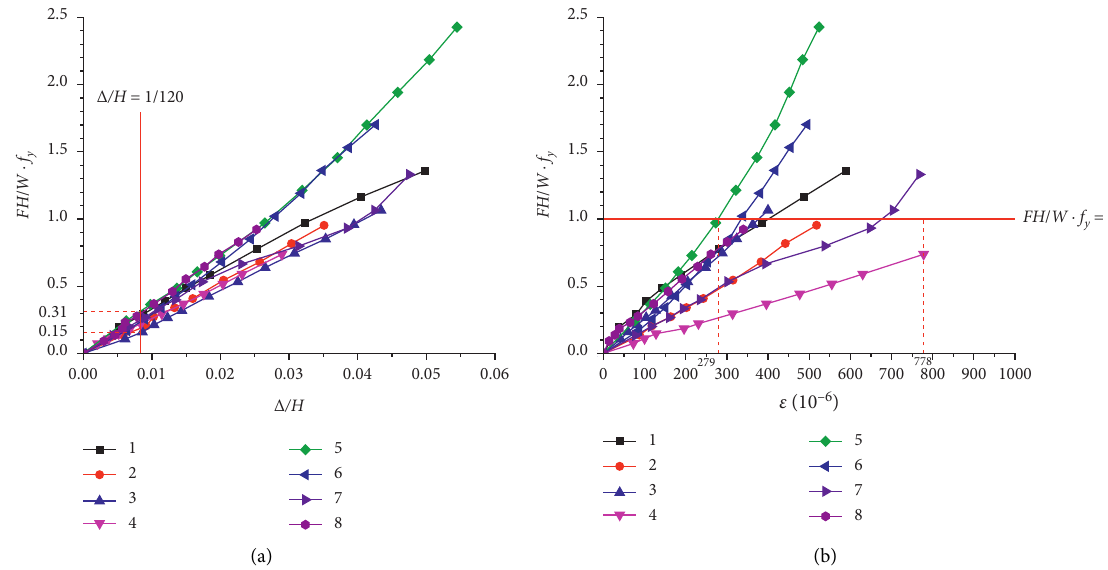
Figure 5: (a) Correlation curve (test results) of ( FH / W · fy ) ∝Δ / H . (b) Correlation curve (test results) of ( FH / W · fy ) ∝ ε .